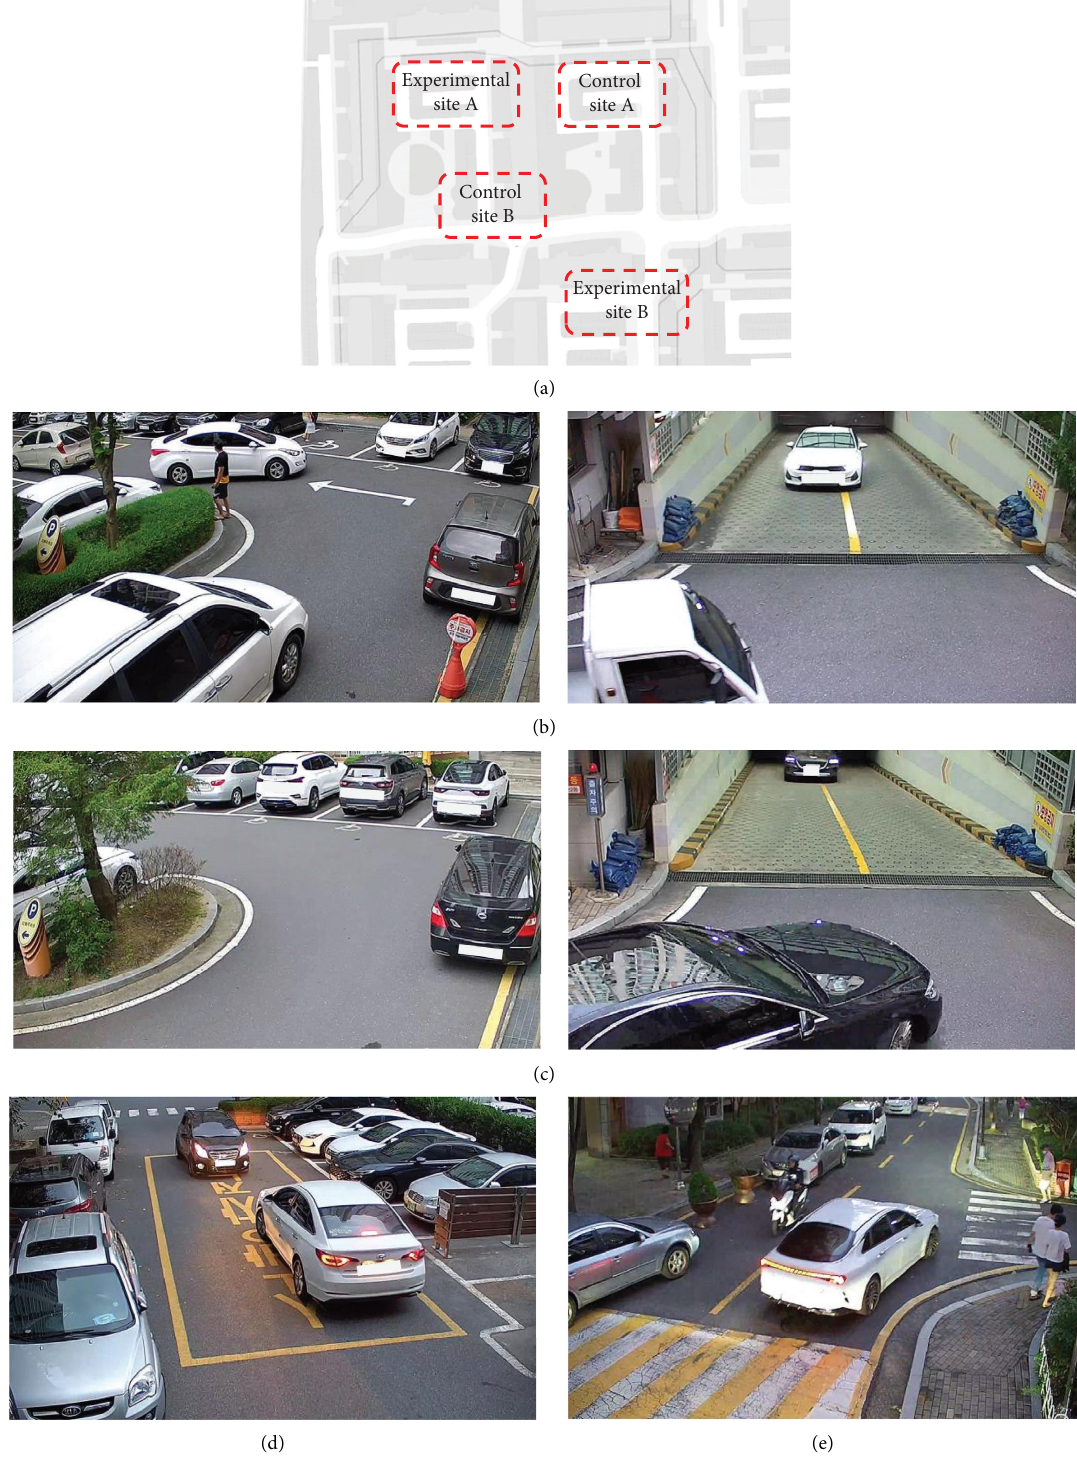
Figure 9: System application at the apartment complex in Daejeon City. (a) Map of two site pairs; (b, c) parking lot and underground parking entrance (experimental and control sites A); (d, e) roadside parking lot (experimental and control sites